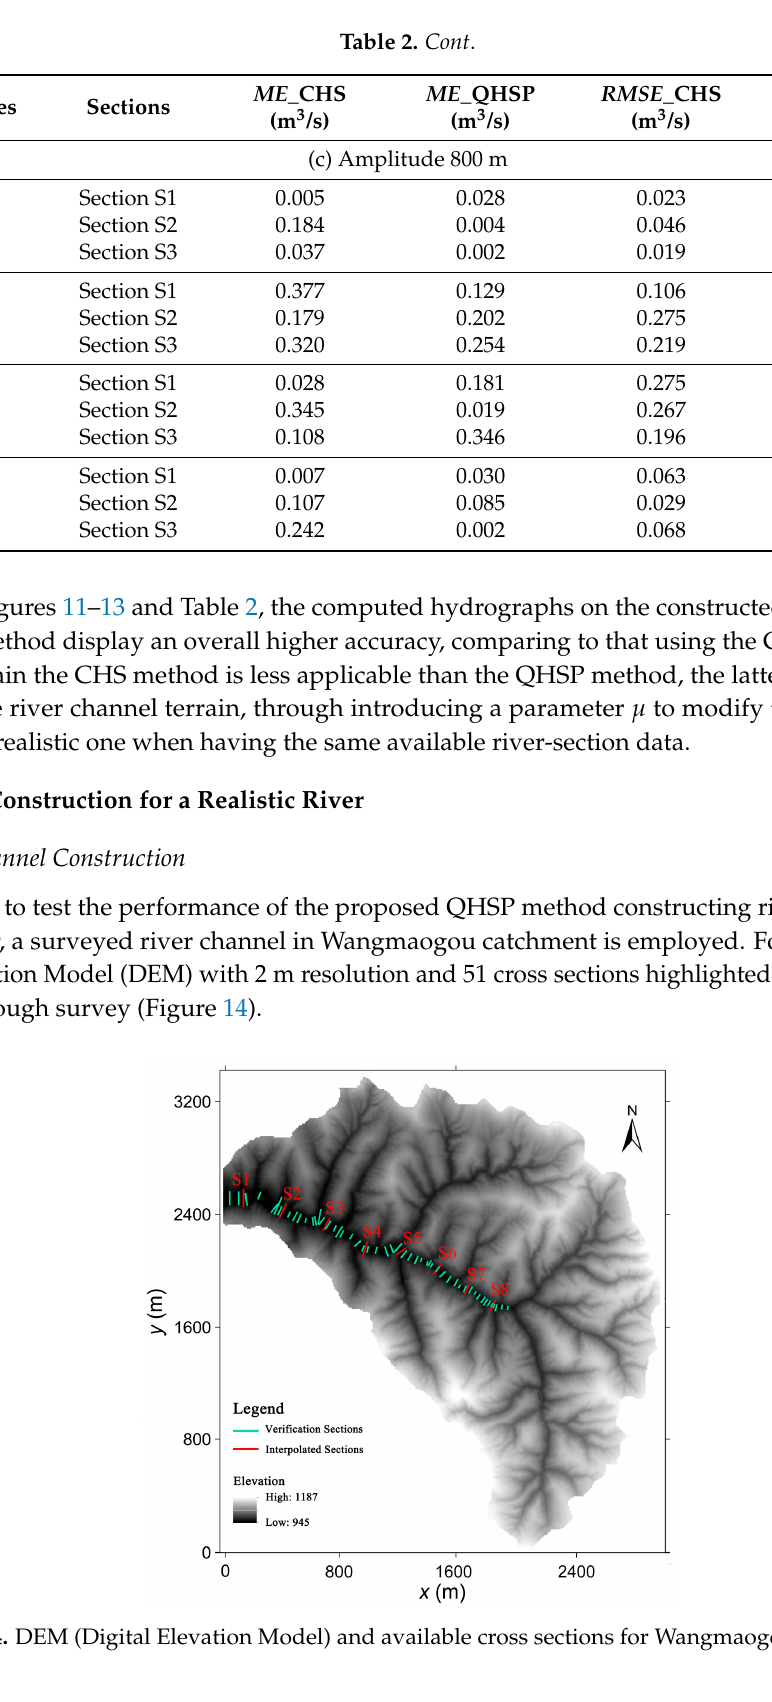
Table 3. Errors of constructed river channel at Wangmaogou catchment by using CHS and QHSP methods.